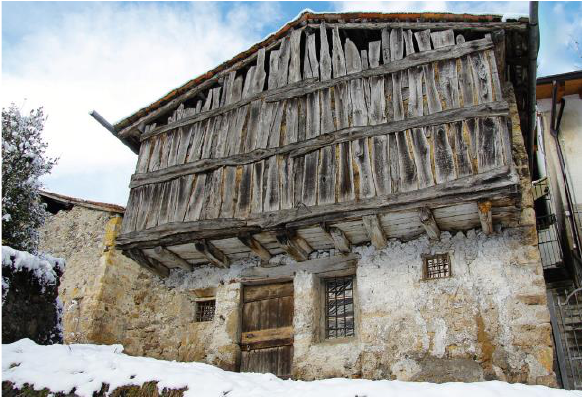
Figure 3. Barn in Ludizzo, Bovegno Brescia (Italy)